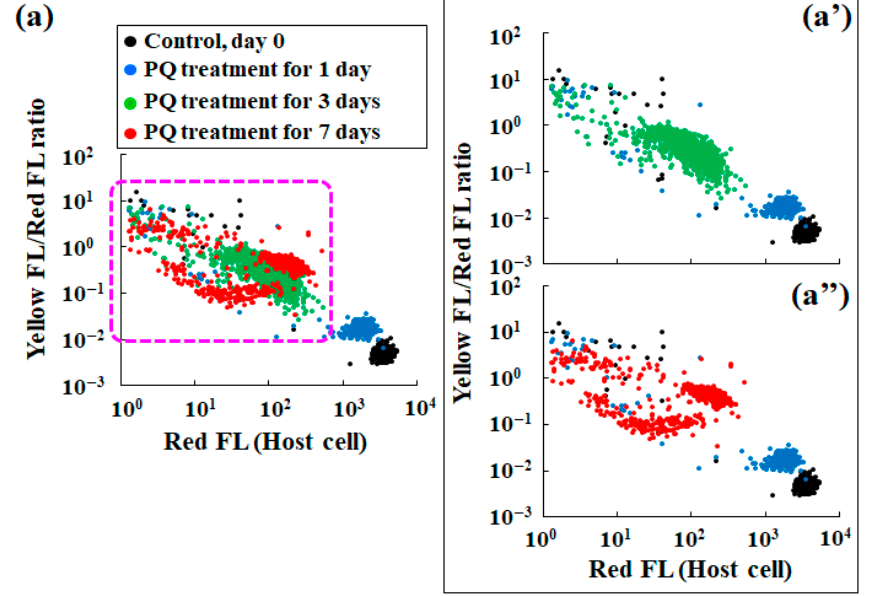
Figure 5. Scatter plots of the red fluorescence intensity (Red FL) vs. the ratio of yellow fluorescence intensity (Yellow FL) to the corresponding Red FL of P. bursaria treated or untreated (control, day 0) with PQ (0.1 µg/mL). ( a ) Scatter plots for the control and PQ-treated (1–7 d) cells. Panel ( a’ ) shows all scatter plots except for the data for the 7 d PQ treatment, and panel ( a’’ ) shows all scatter plots except for the data for the 3 d PQ treatment.